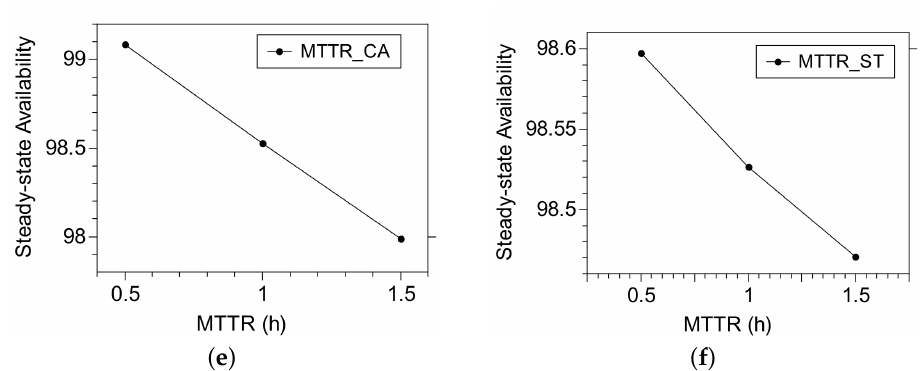
Figure 5. Availability results varying the mean time to repair ( MTTR )/ MTTF : ( a ) MTTF_CA (camera); ( b ) MTTF_HW (hardware); ( c ) MTTF_ST (storage); ( d ) MTTF_OS (operating system); ( e ) MTTR_CA (camera); and ( f ) MTTR_ST (storage).